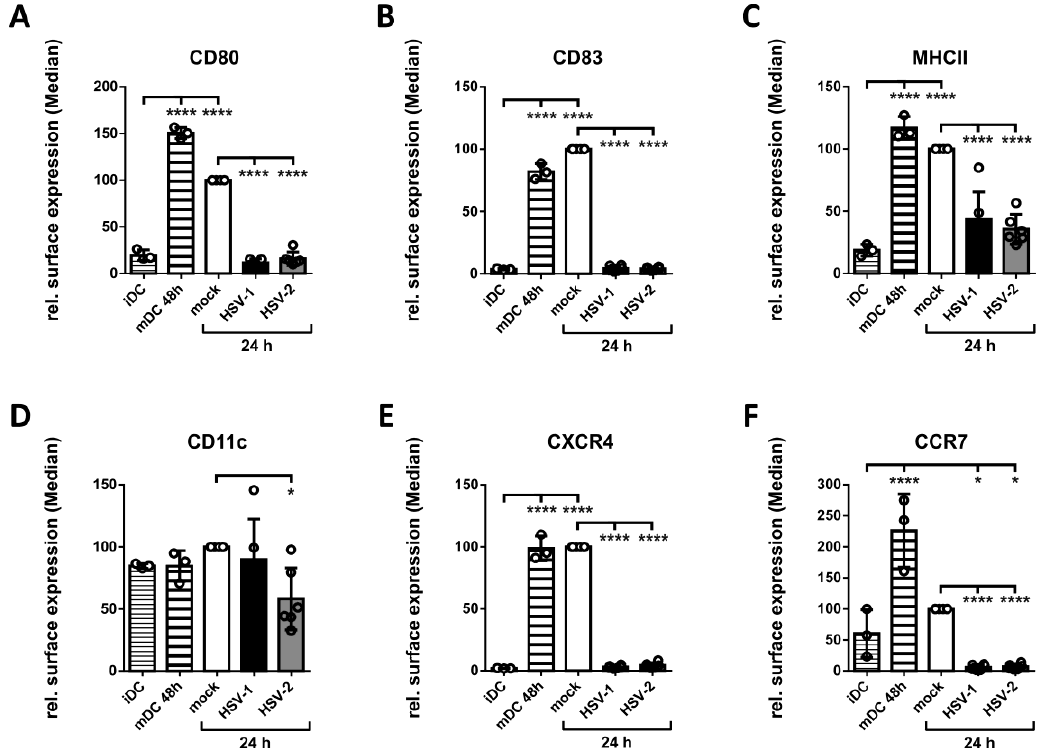
Figure 2. HSV-2 inhibits DC maturation. Immature DCs were generated and either directly used for flow cytometric analyses, serving as input control, or mock-, HSV-1- (MOI of 2) and HSV-2-infected (MOI of 5) followed by addition of the maturation cytokine cocktail. After 24 h, DCs were subjected to flow cytometric analyses. Additionally, 48 h matured mock-treated DCs served as a positive control. The cells were stained with specific fluorochrome-labeled antibodies directed against ( A ) CD80, ( B ) CD83, ( C ) MHCII, ( D ) CD11c, ( E ) CXCR4, and ( F ) CCR7. Median values are shown as percentages relative to 24 h matured mock-treated DCs. The experiment was performed at least three times with cells from different healthy donors. Error bars indicate ± SD. Significant changes (**** = p < 0.0001; * = p < 0.05) are marked by asterisks.